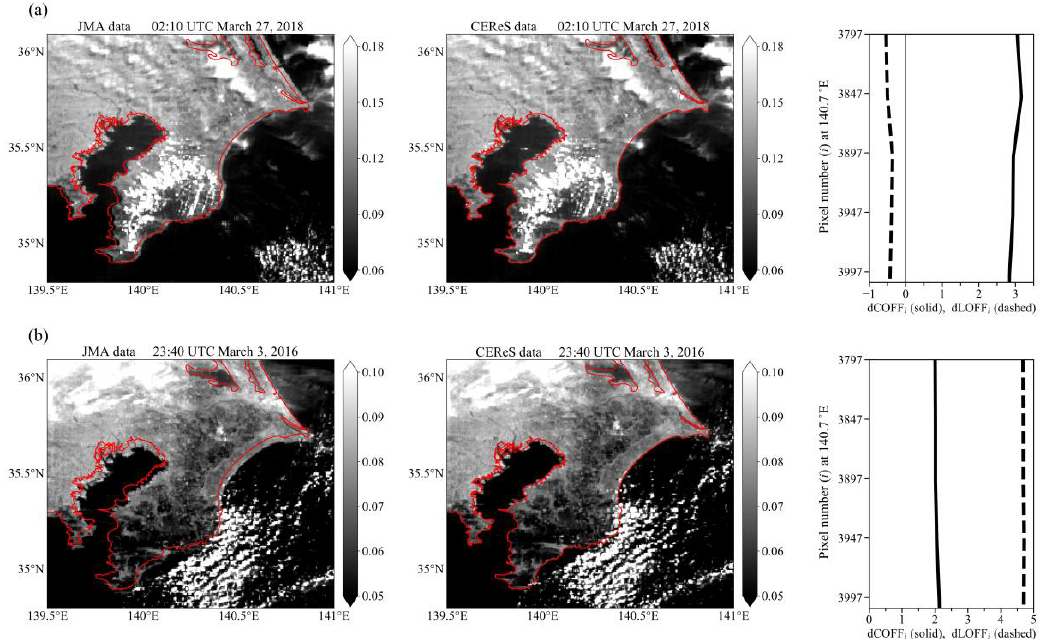
Figure 2. An example of band 3 reflectance images from Japan Meteorological Agency (JMA) data (left) and CEReS data (center) for case ( a ) large positive dCOFF i at 02:10 UTC on March 27, 2018 and case ( b ) large positive dLOFF i at 23:40 UTC on March 3, 2016. dCOFF i and dLOFF i profiles corresponding to the scans (i = 3797, 3798, ... , 4006) (right) for the area shown in the left-hand images. The mean values of dCOFF and dLOFF for case ( a ) are 2.99 pixels and -0.43 pixels, respectively; for case ( b ) these are 2.04 pixels and 4.69 pixels,